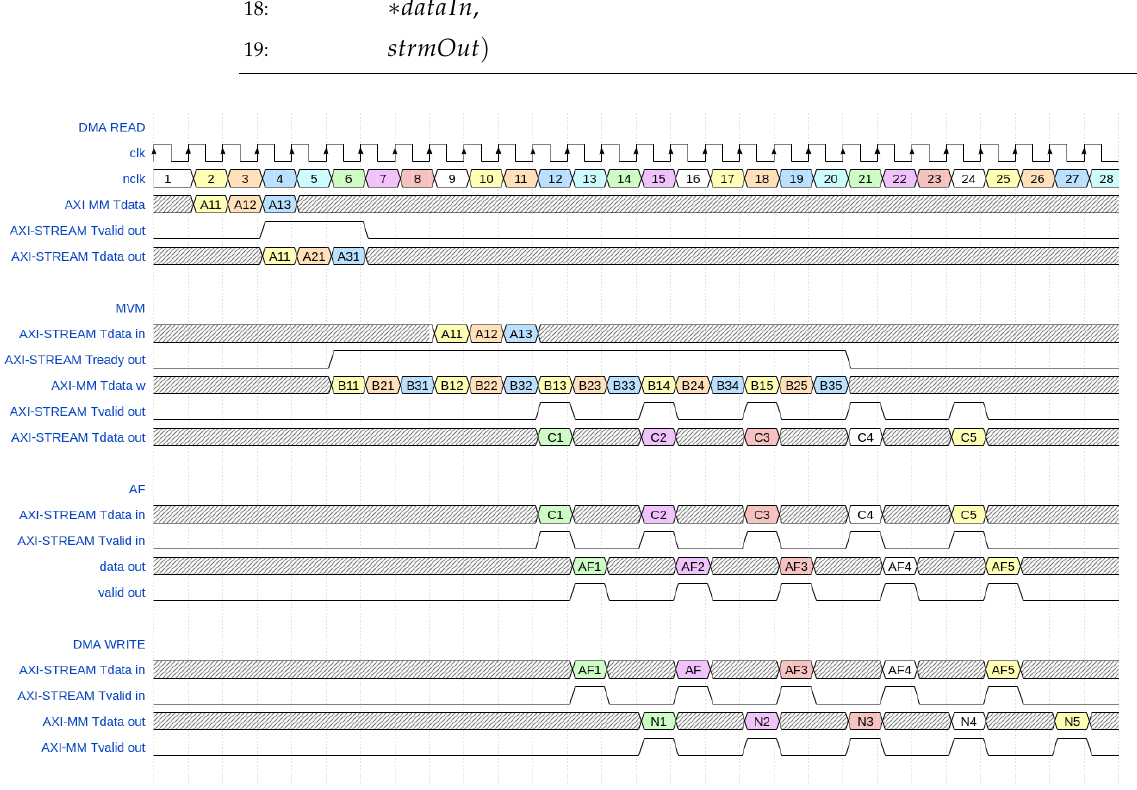
Figure 4. Waveform clock for a ANN PE layer, example of 3 input layer and 5